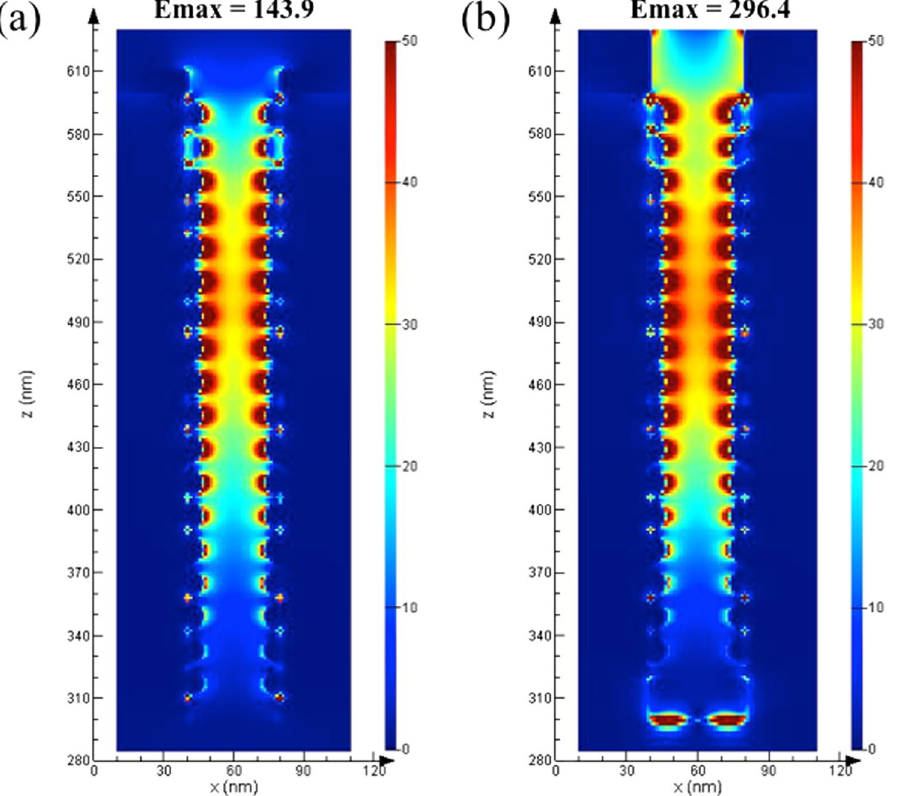
Figure 3. FDTD simulation results of the electrical field intensity for ( a ) Control group (SERS substrate composed by SiNWA with AuNPs). ( b ) Trail #8 SERS substrate (SERS substrate composed by SiNWA with AuNPs and AuMBP). (Note that the diameter of AuNPs on the sidewall is set as 13 nm, the distance between SiNWA is set as 40 nm, and the thickness of AuMBP at the bottom is set as 20